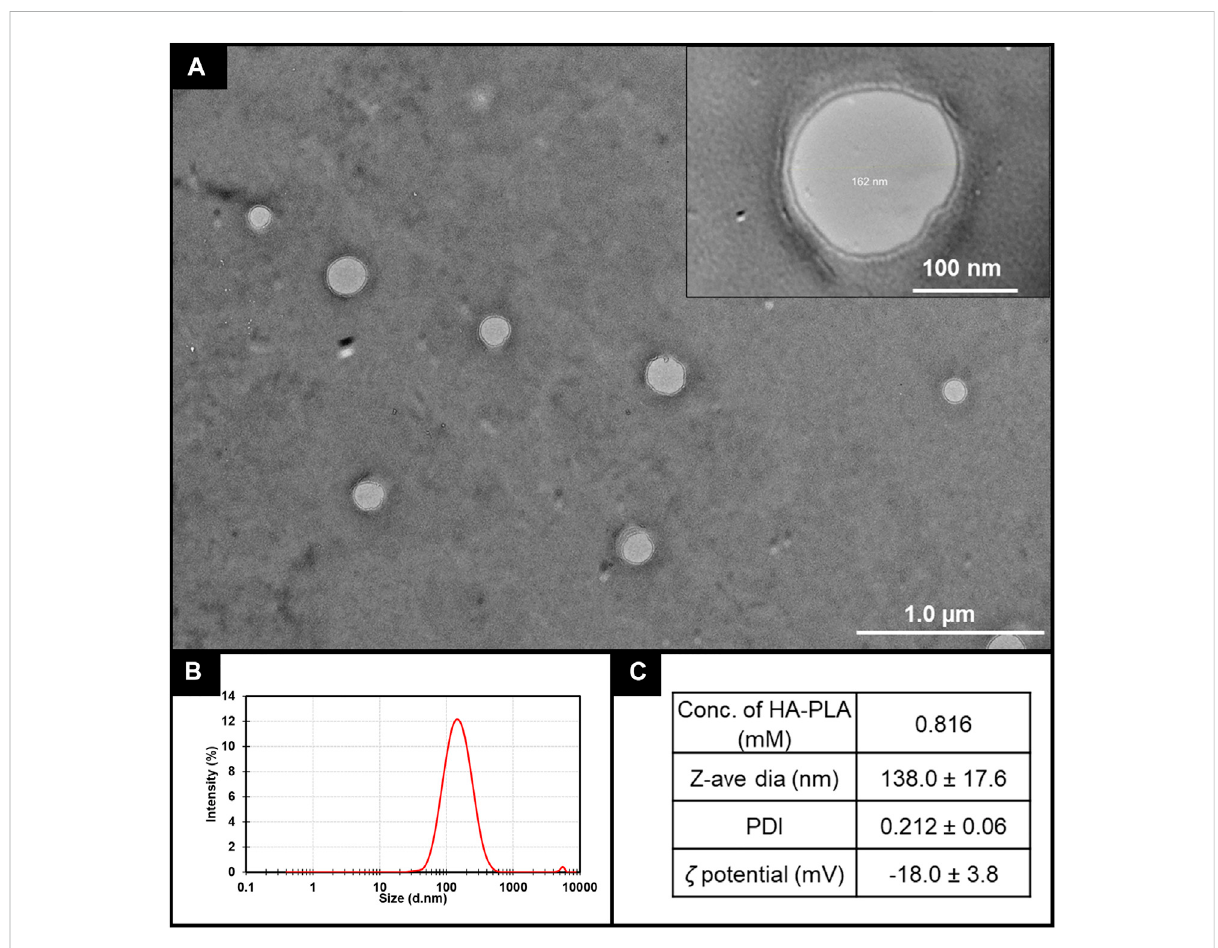
FIGURE 4 Hyaluronic acid-polylactic acid (HA-PLA) polymersome characterization (A) The vesicular morphology of HA-PLA polymersomes observed by transmission electron microscope (scale bar: 1 μ m, inset: 100 nm), (B) the size distribution of HA-PLA polymersomes observed by dynamic light scattering(n=4), (C) theconcentrationofHA-PLAusedinsolventinjectionmethod,Z-averagediameter,polydispersityindexand ζ - potentialofHA- PLA polymersomes measured using dynamic light scattering (n =